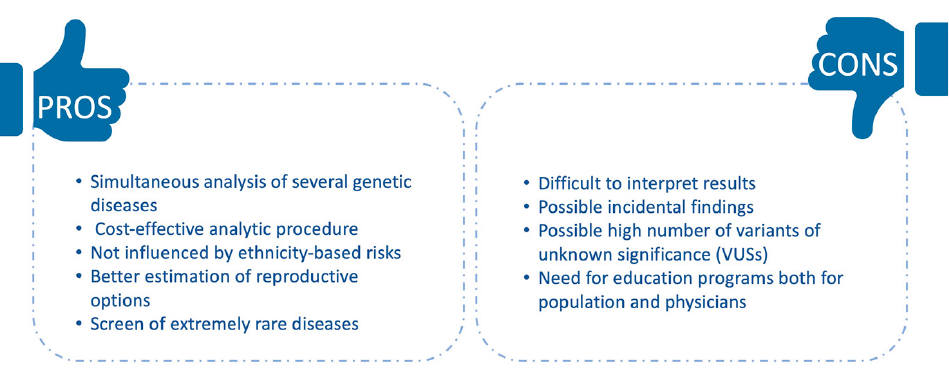
Figure 1. Pros and cons of ECS testing.